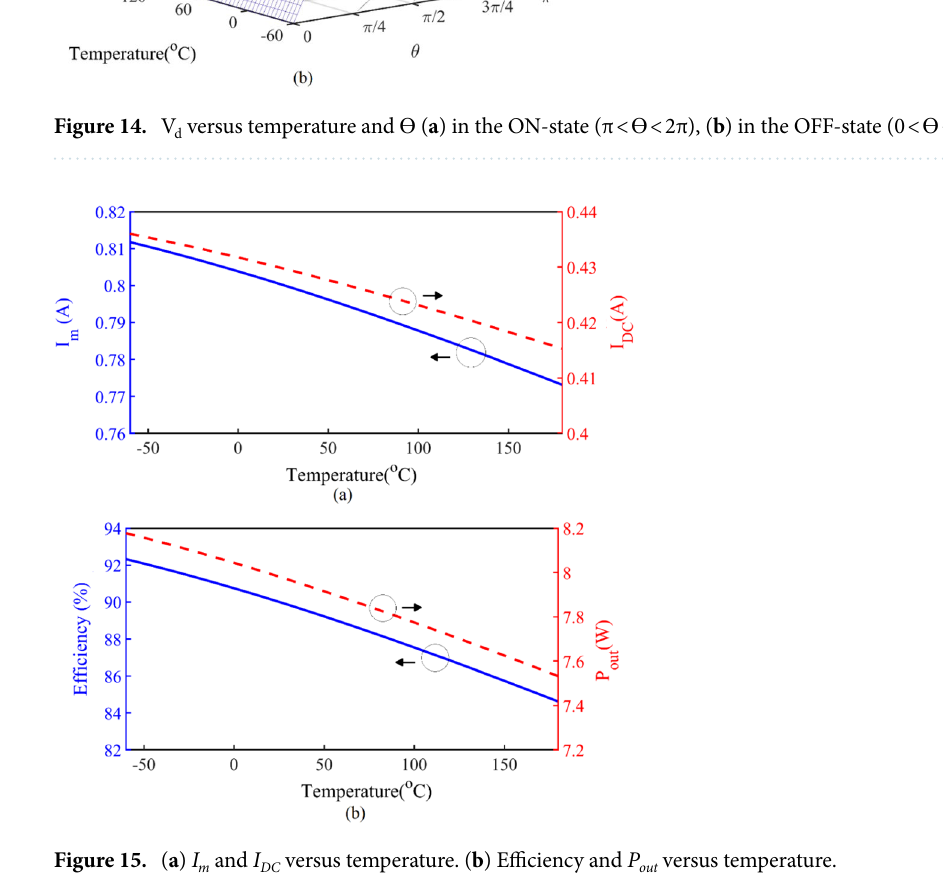
Figure 15. ( a ) I m and I DC versus temperature. ( b ) Efficiency and P out versus